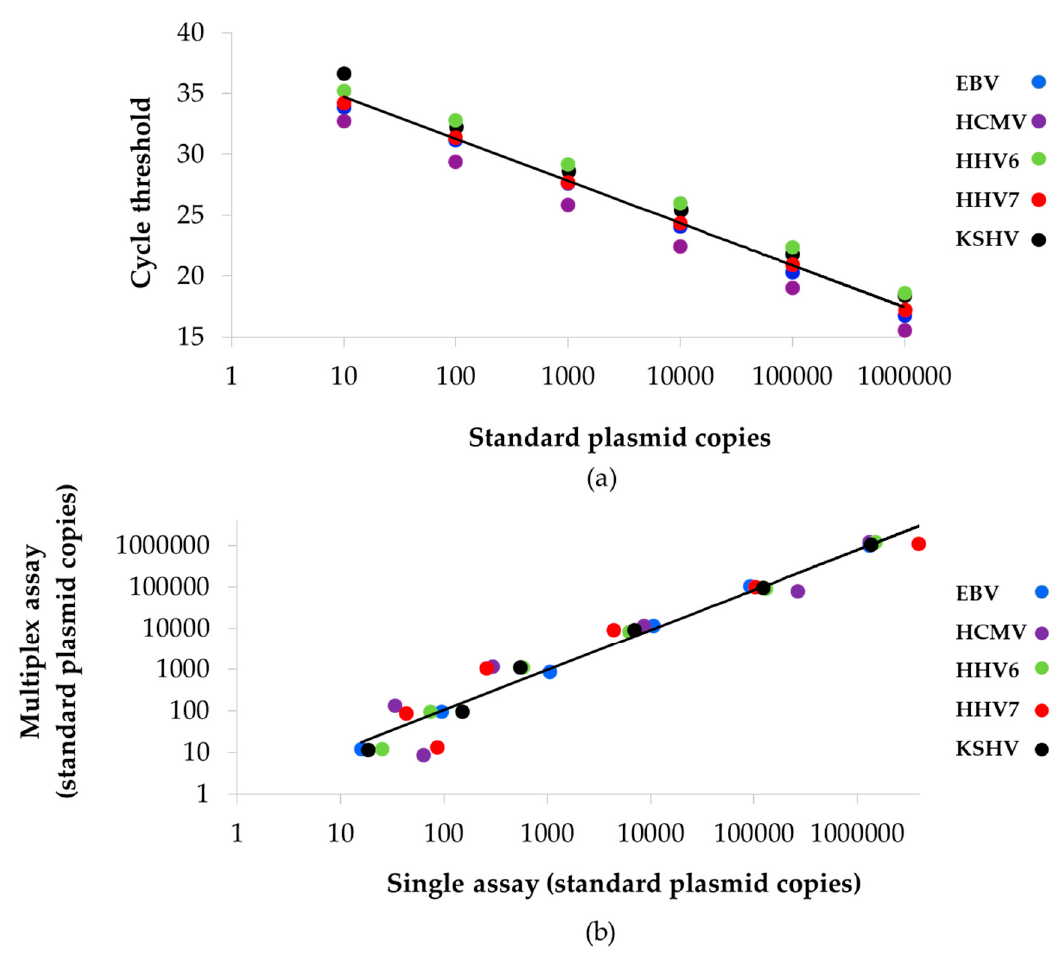
Figure 2. Standardization of the two-tube multiplex qPCR. ( a ) Serial dilutions of standard plasmids (10 6 –10 1 copies) were used to construct standard curves. The number of copies detected for each standard plasmid dilution was plotted against the average of the cycle threshold. Efficiencies and coefficient of determination R 2 values (predictability) are shown in Table 2. ( b ) Correlation of viral copy numbers detected in multiplex vs. single assays. Correlation coefficients (R) are shown in Table 2.